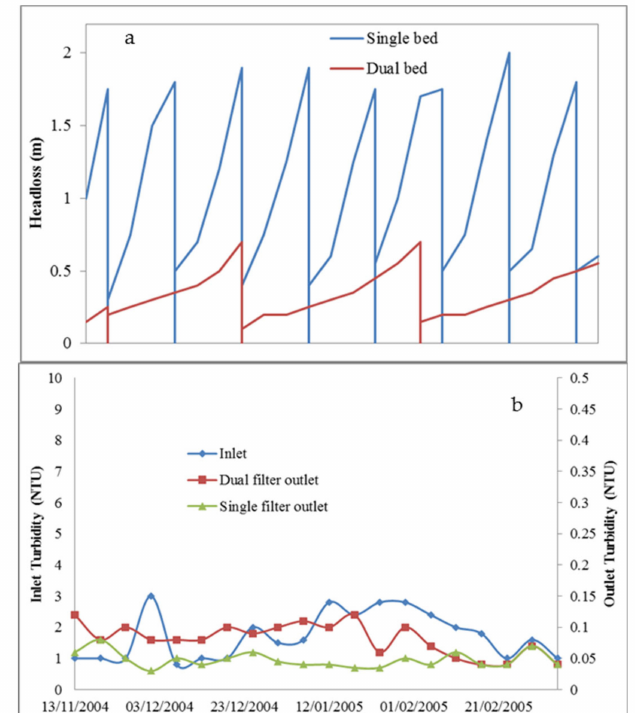
Figure 4. ( a ) Head loss development (19 / 02 / 2005–25 / 02 / 2005) and ( b ) values of turbidity for conventional treatment (reprepared using the data from